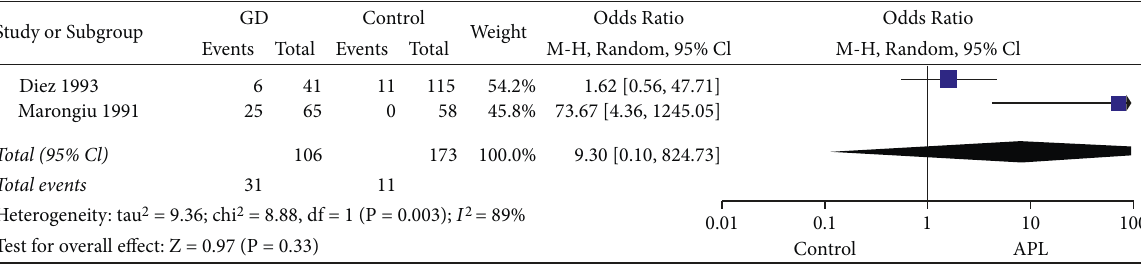
Figure 3: Forest plots for the prevalence of positive aPL in GD patients compared with healthy controls. GD: Graves’ disease; APL: antiphospholipid antibodies; CI: confidence interval.